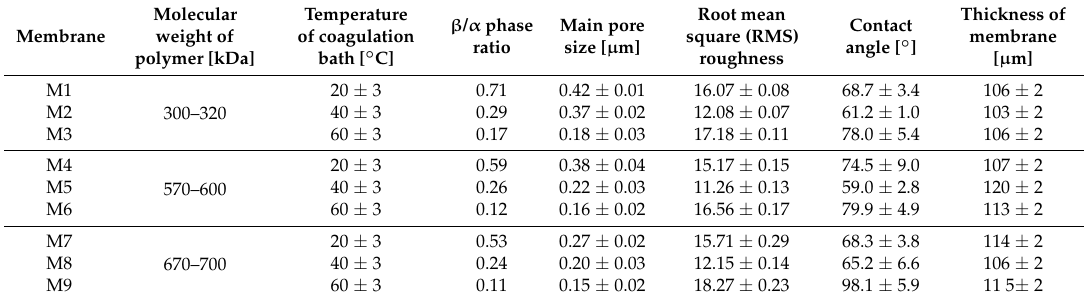
Table 1. M1–M9 membrane preparation parameters, and the characteristics of the resulting membranes.